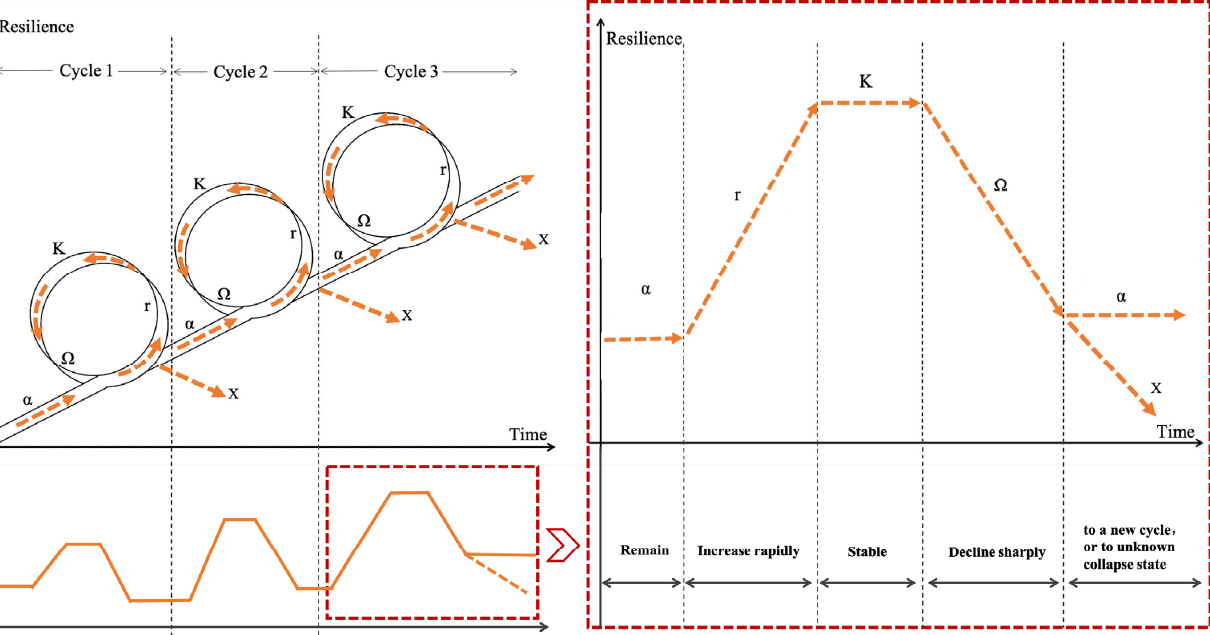
Figure 3. Dynamics identification of resilience by adaptive cycle framework.